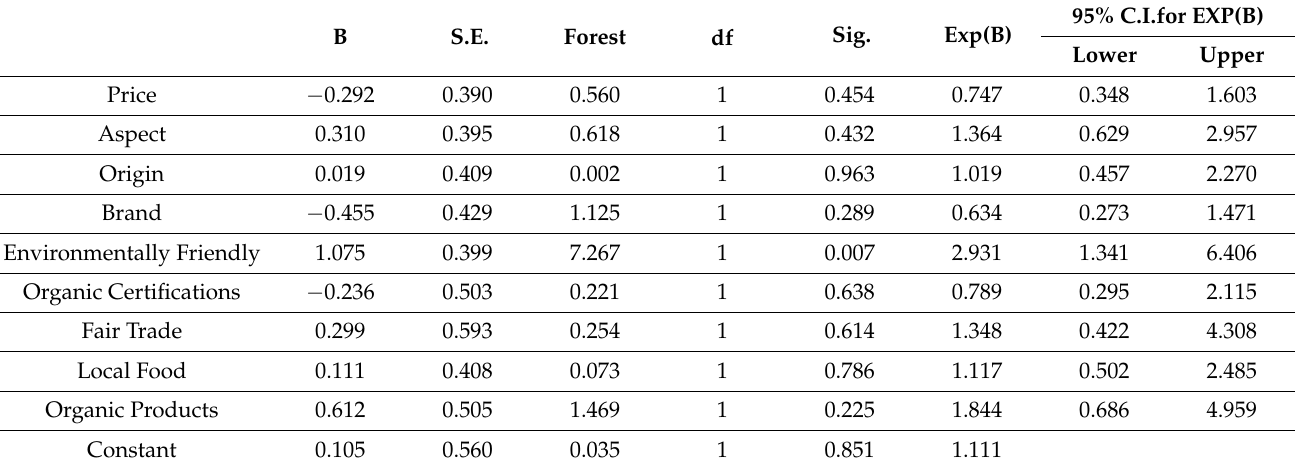
Table 2. Spanish sample. Output of logistic